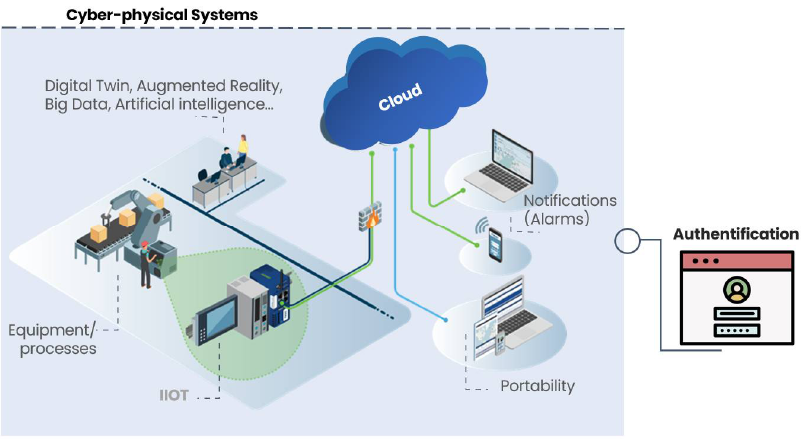
Figure 16. The proposed multifunctional platform of predictive maintenance based on industrial asset management.